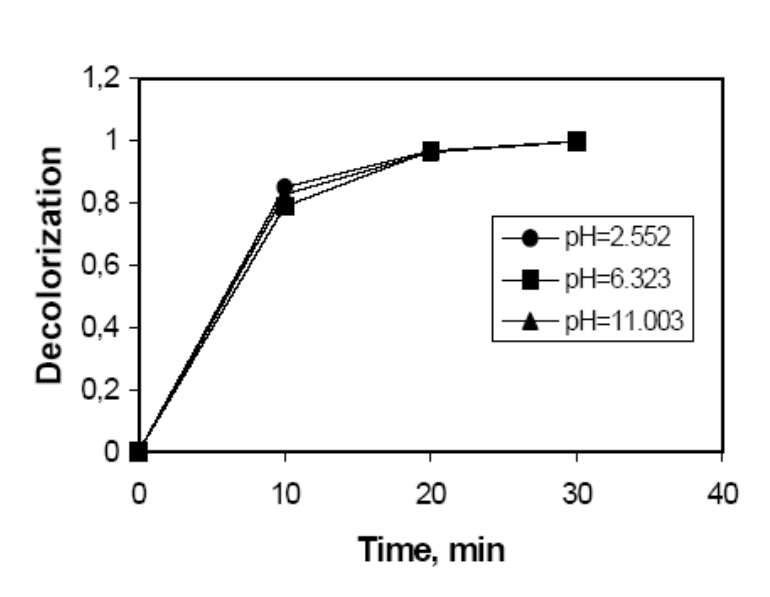
Fig. 4 Effect of pH on the decolorization of Acid Red G azo dye. Initial conditions: C dye =50 mg/L, [H 2 O 2 ]= 17.318 mM.